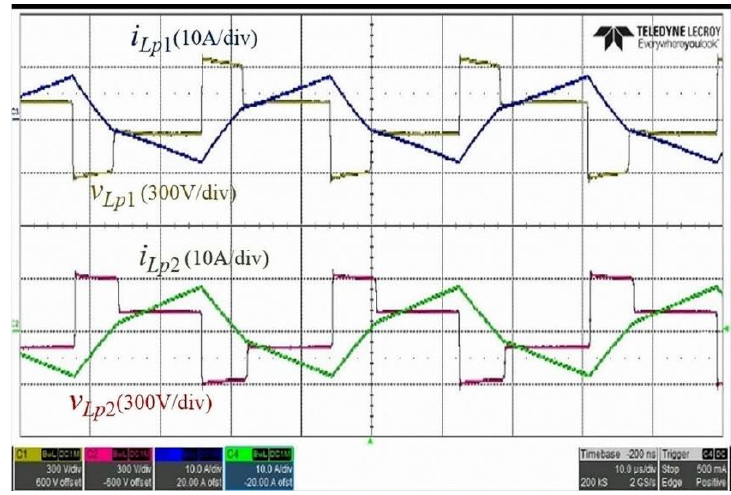
Figure 14. Experimental waveforms of the gate-to-source and drain-to-source voltage waveforms for S 1 and S 2.